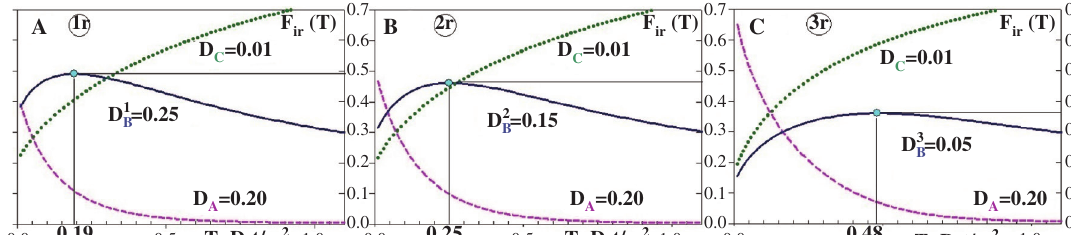
1-3 various, nonmonotonous F B